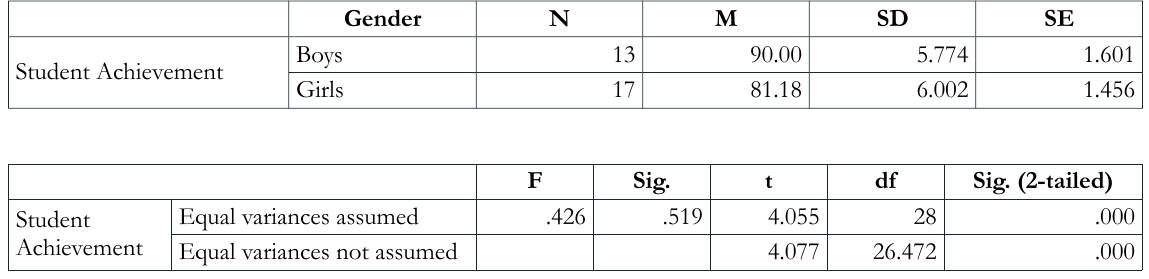
Table 3. The results of independent t-test of t-test between boys and